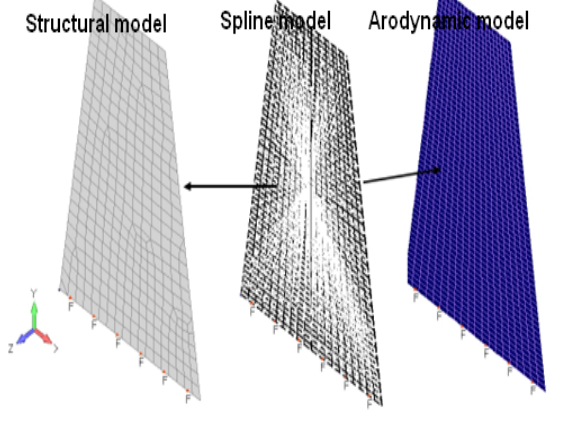
Figure 10. Tapered plate mode